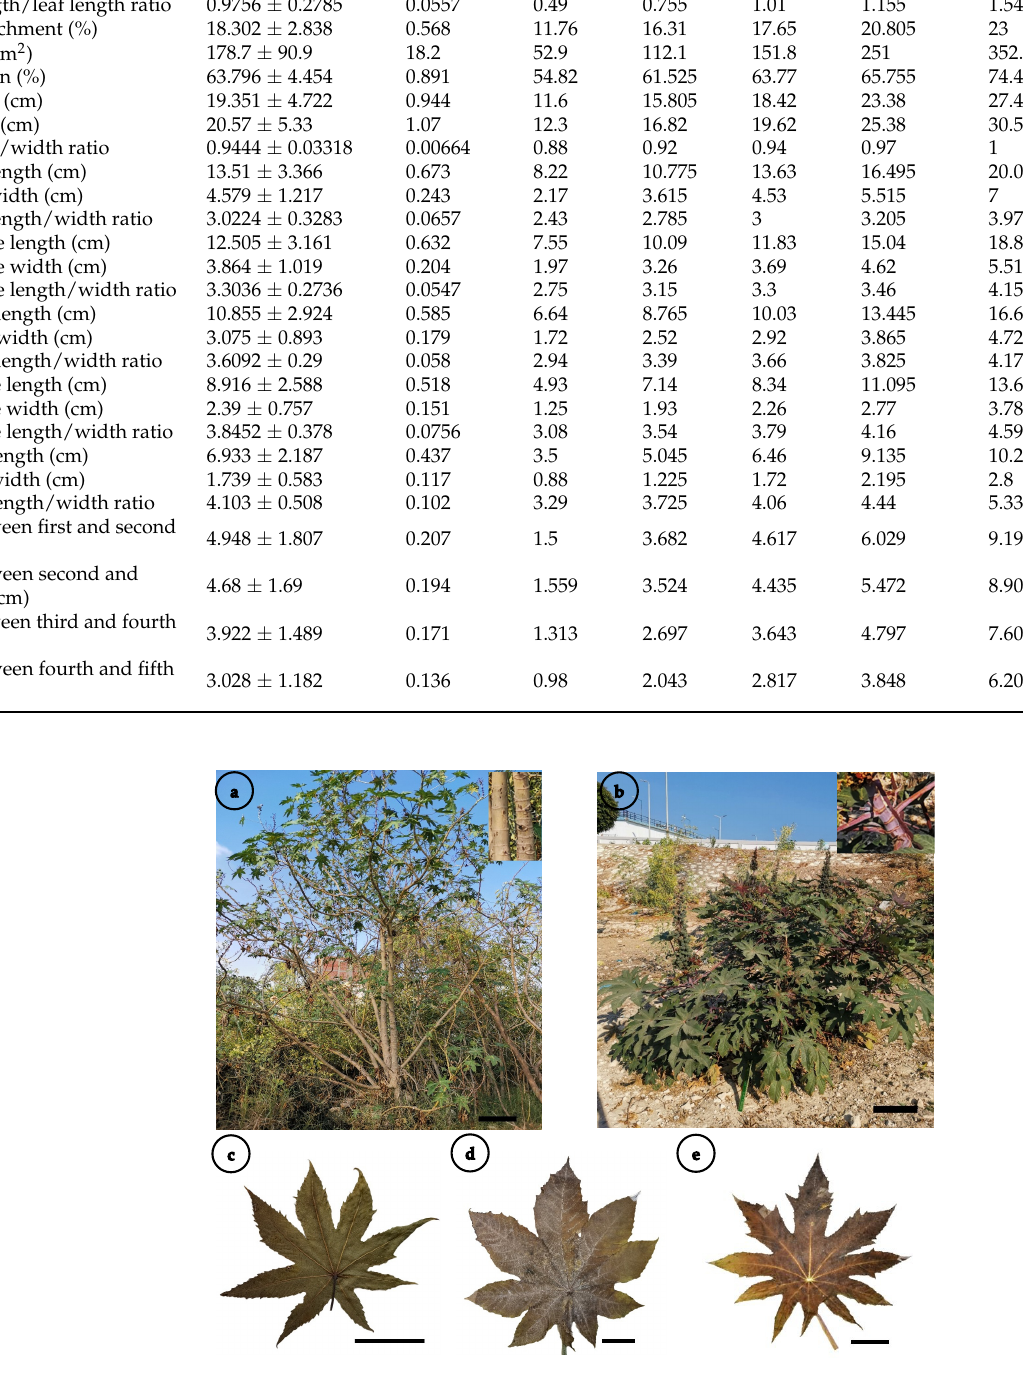
Figure 2. ( a , b ) Photographs of Ricinus communis : ( a ) very tall grayish-green stem showing both condensed and elongated internodes (sample no 7), ( b ) short purple-waxy stem (sample no 4). ( c – e ) Dried herbarium leaves of the plant: ( c ) mesophyll blade with lanceolate lobes (sample no 11) and ( d , e ) macrophyll blade. ( d ) First, second and third lobes are oblong and the fifth is lanceolate (sample no 24). ( e ) First, second and third lobes are lanceolate and the fifth is linear-lanceolate (sample no 17). Scale bar = 30 cm ( a , b ); 4 cm ( c – e